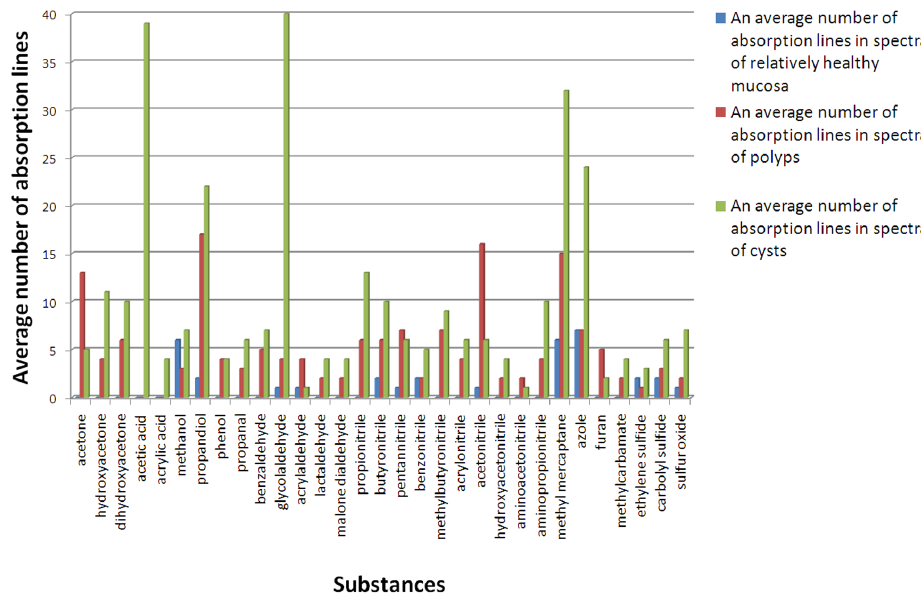
Figure 8. The chemical composition of products of thermal decomposition for samples of relatively healthy mucosa (blue), cyst (green), and polyp (red).